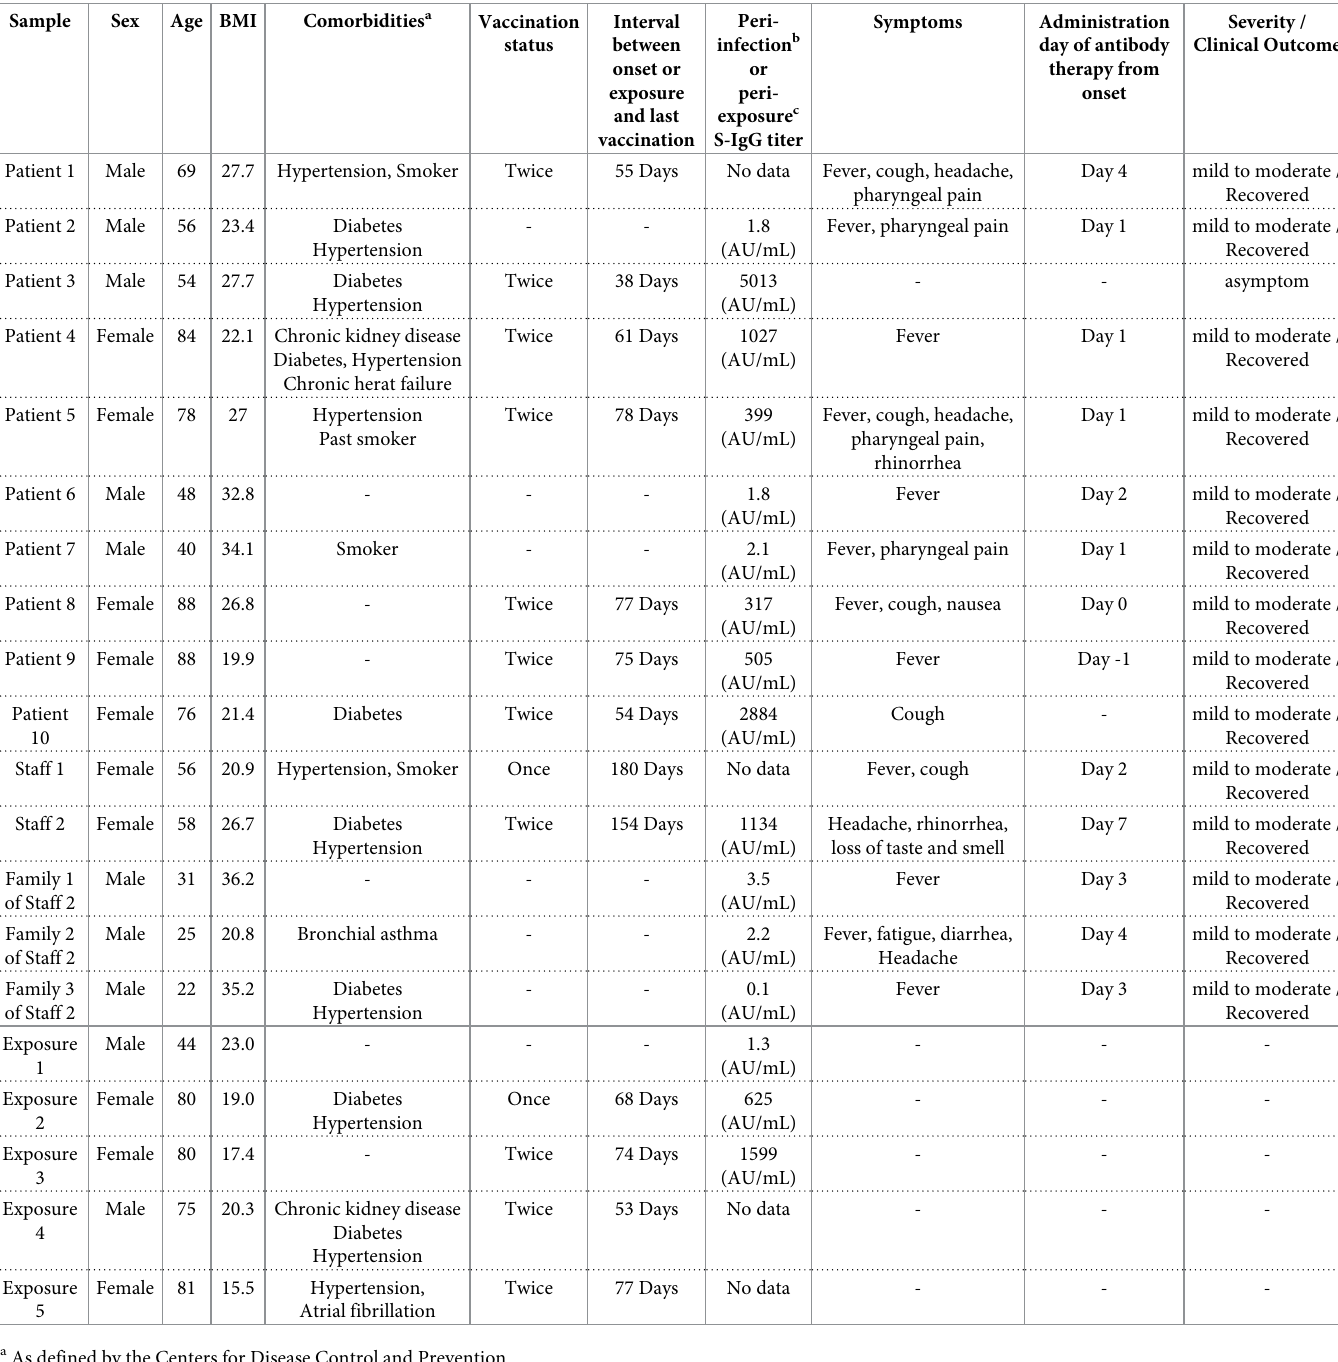
Table 1. Clinical characteristics, vaccine history, and symptoms associtated with COVID-19 of infected persons and uninfected close exposures. Sample Sex Age